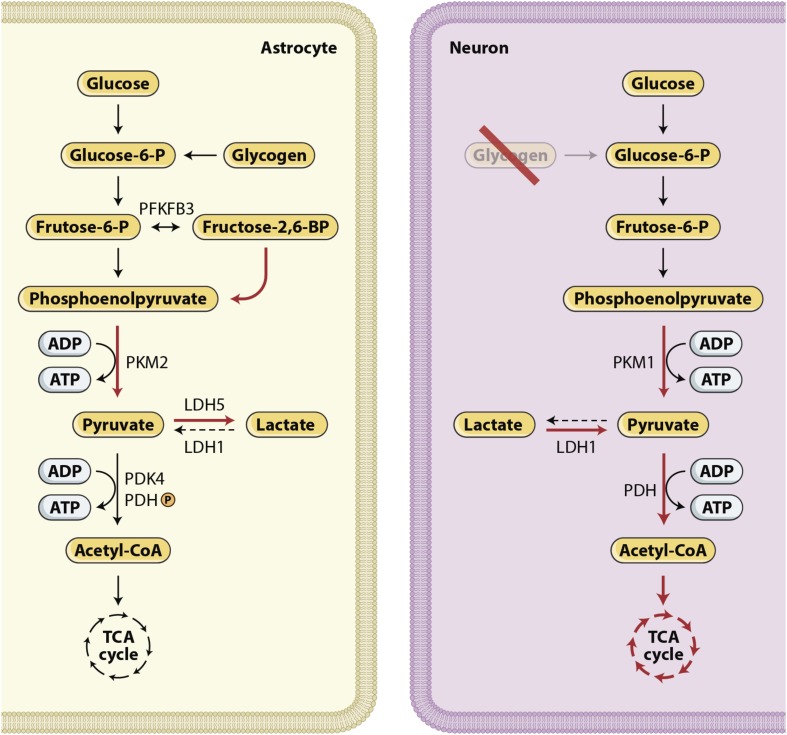
Glucose metabolism in the brain. The expression of different metabolic pathways for glucose is cell specific. Red arrows show upregulated pathways and black dashed arrows show downregulated pathways. Lactate production characterize astrocytes, whereas neurons use a significant proportion of glucose in the PPP (Bouzier-Sore and Bolanos, 2015) and use lactate, after its conversion to pyruvate, as their preferred mitochondrial energy substrate (Patet et al., 2016; Magistretti and Allaman, 2018). In summary, these cell-specific expression and activity profiles confer to neurons a restricted potential for upregulating glycolysis and an active oxidative phosphorylation activity. By contrast, in astrocytes, aerobic glycolysis is favored and oxidative activity is limited.